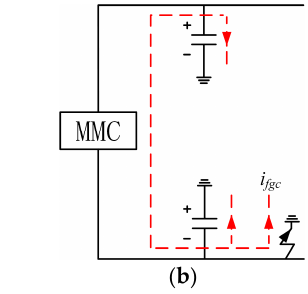
Figure 6. Fault current circuit of i fgc . ( a ) Positive pole-to-ground fault; ( b ) Negative pole-to-ground fault.